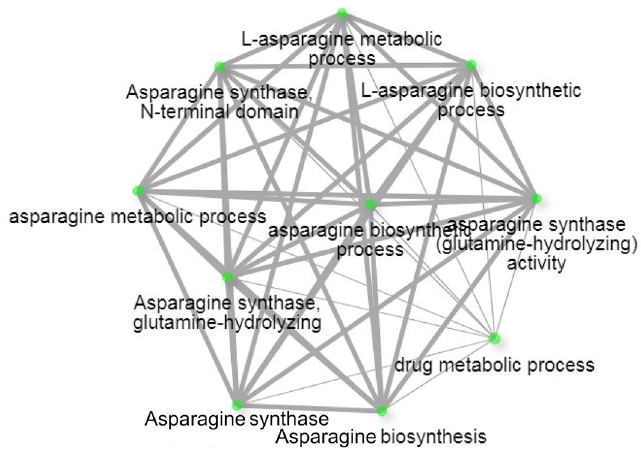
Figure 5. Network display of five grain related genes underlying identified MQTL involved in asparagine biosynthesis and metabolism pathways having significant role in regulating source to sink relation in rice. The green nodes in the network indicate different asparagine biosynthesis and metabolic pathways and grey connecting lines indicate interaction between the processes of pathways to contribute towards establishing source to sink relationship.